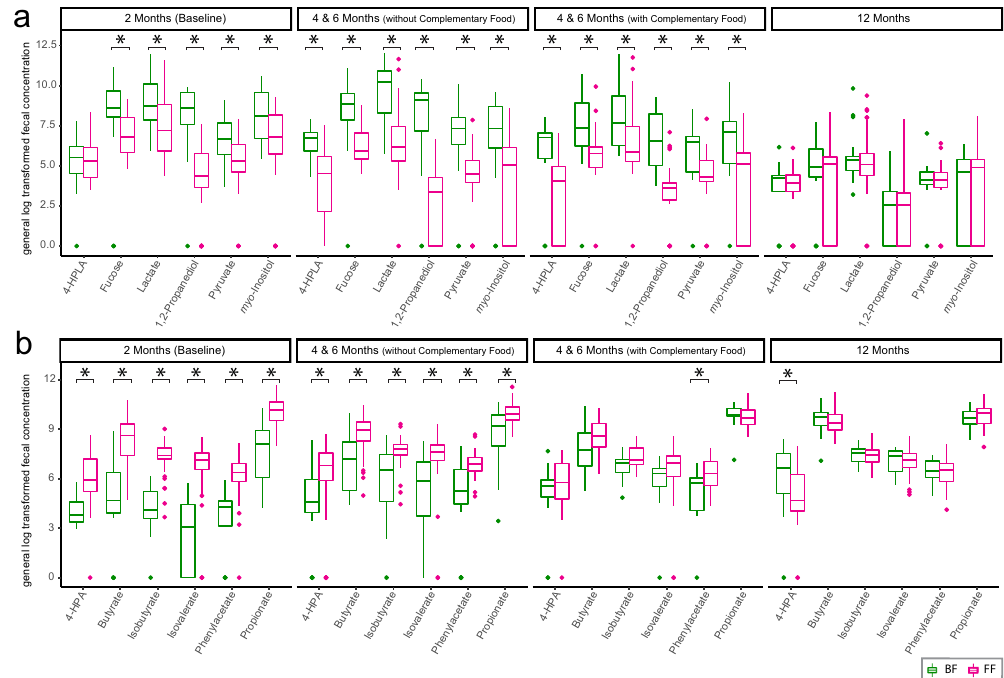
Figure 6. Significantly differentiating fecal metabolites that are ( a) higher and ( b ) lower in breast-fed (BF, green) than formula-fed (FF, red) infants. The group differences were evaluated using Kruskal-Wallis H test by FDR correction at p < 0.05. The complete list of differentiating metabolites is in SI Fig. 5. Abbreviation: 4-HPLA: 4-hydroxyphenyllactate, 4-HPA: